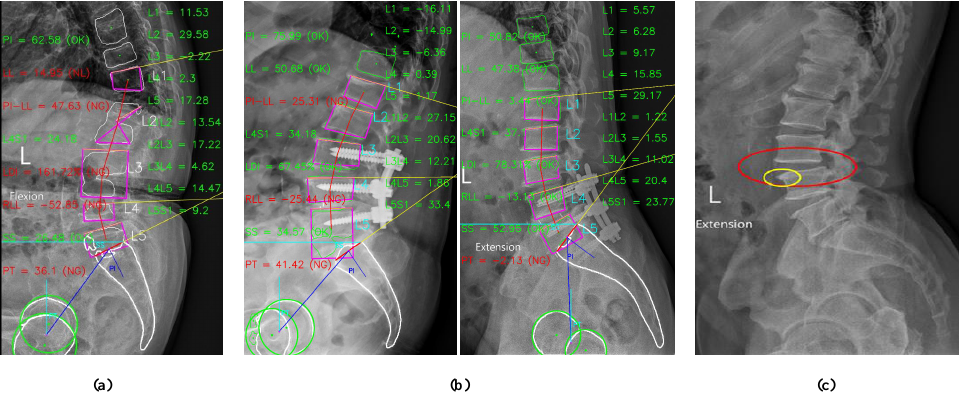
Figure 12. Errors in processing due to ( a ) osteoporosis makes poor image quality, ( b ) superimposition between the pelvis and vertebrae, and ( c ) vertebral